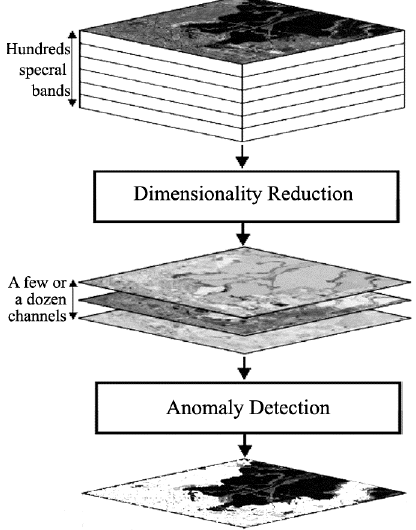
Figure 1. Flowchart of hyperspectral AD using the pre- processing DR